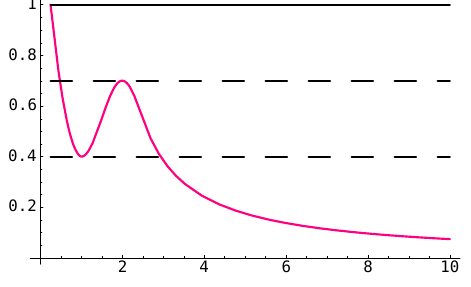
Figure 2. Function U ( λ ) , A and B are respectively the local minimum and maximum marked with dashed